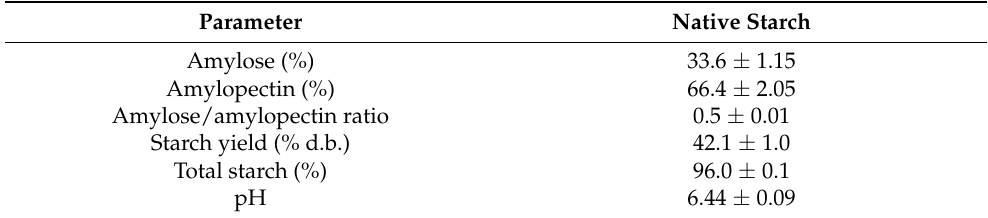
Table 2. Mean ± standard deviation of the physicochemical characteristics of Talisia floresii Standl native starch.